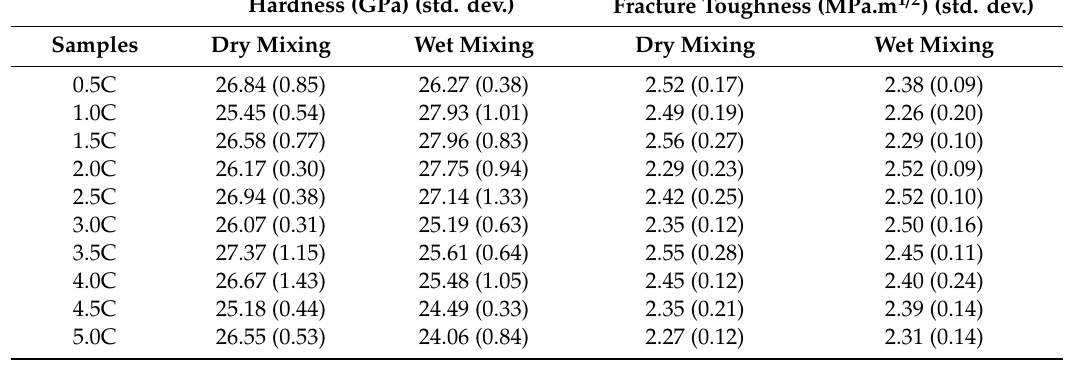
Table 4. Dry mixed and wet mixed SiC samples hardness and fracture toughness values.